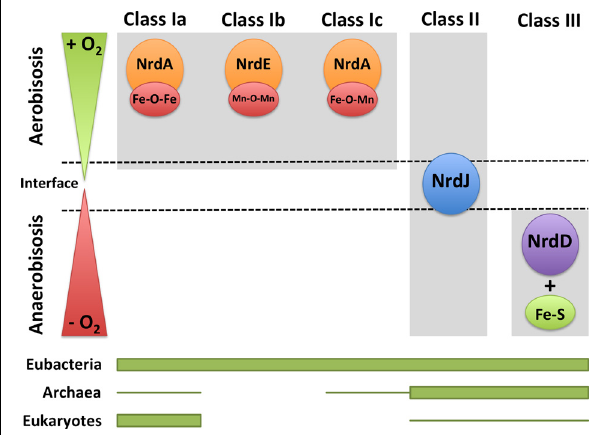
FIGURE 3 | RNRs as survival markers under aerobic or anaerobic environments. RNR classes can be activated under different environmental conditions in which one organism survives depending on the oxygen availability (aerobic, anaerobic, and in the interface). The distribution of each RNR class in the three domains of life (eubacteria, archaea, and eukaryotes) is shown. The thicker line represents higher RNR class occurrence, and the thinner line corresponds to the occurrence in only a few